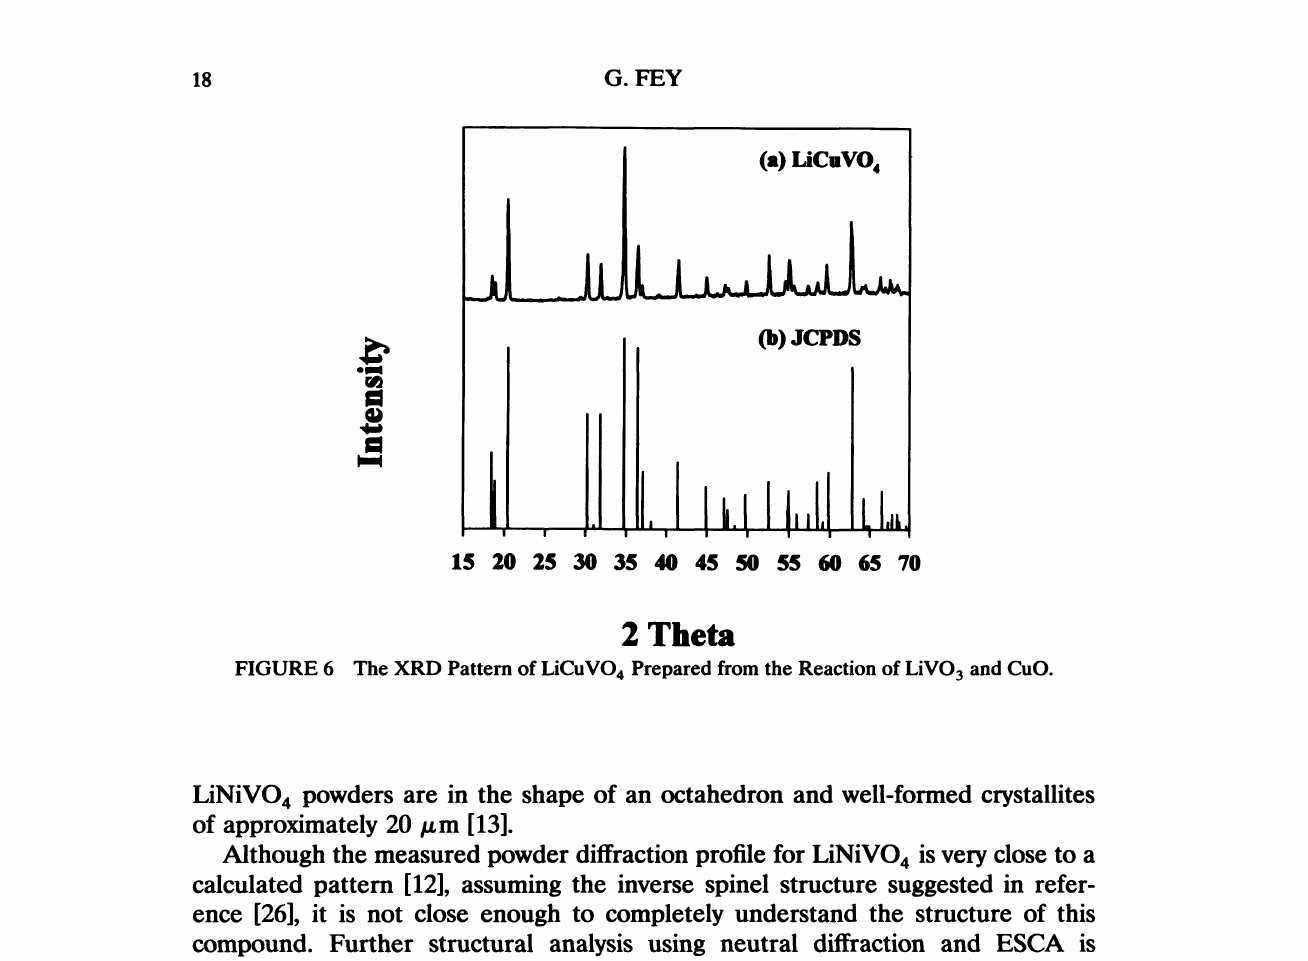
FIGURE 6 The XRD Pattern of LiCuVO